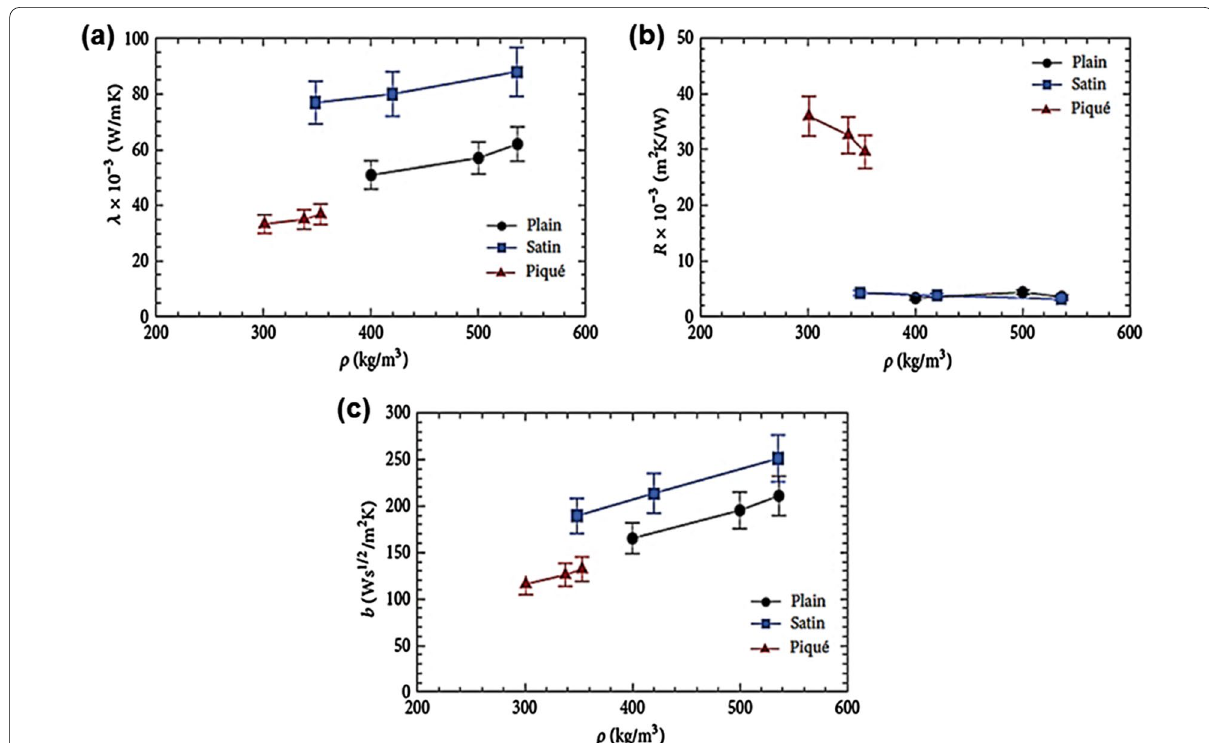
Fig. 10 The thermal properties versus density of cotton fabrics: a thermal conductivity; b resistance and c absorption [90] Copyright 2016 International Journal of Polymer